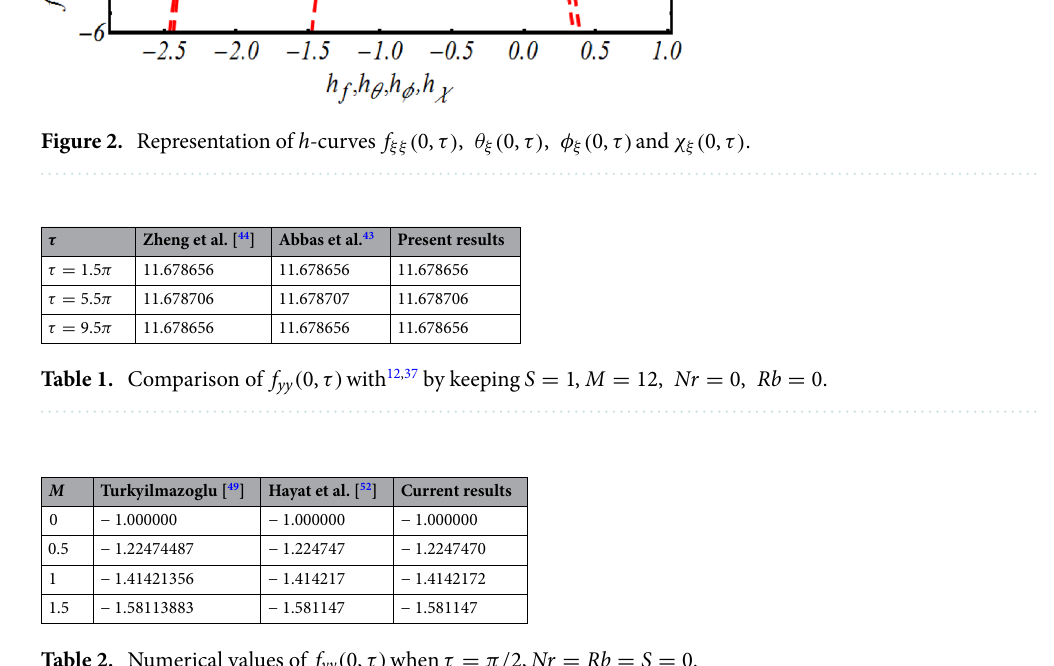
Table 2. Numerical values of f yy ( 0, τ) when τ